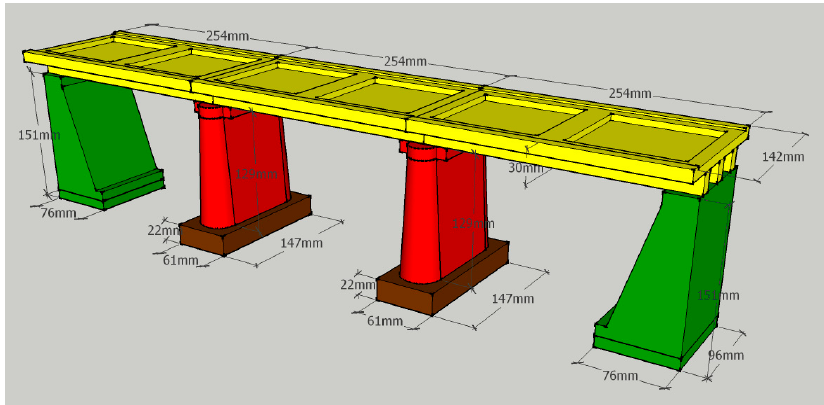
Figure 6. 1:37 scale model of the Yabitsu Bridge. Table 2. Dimensions of debris used for damming the pier.